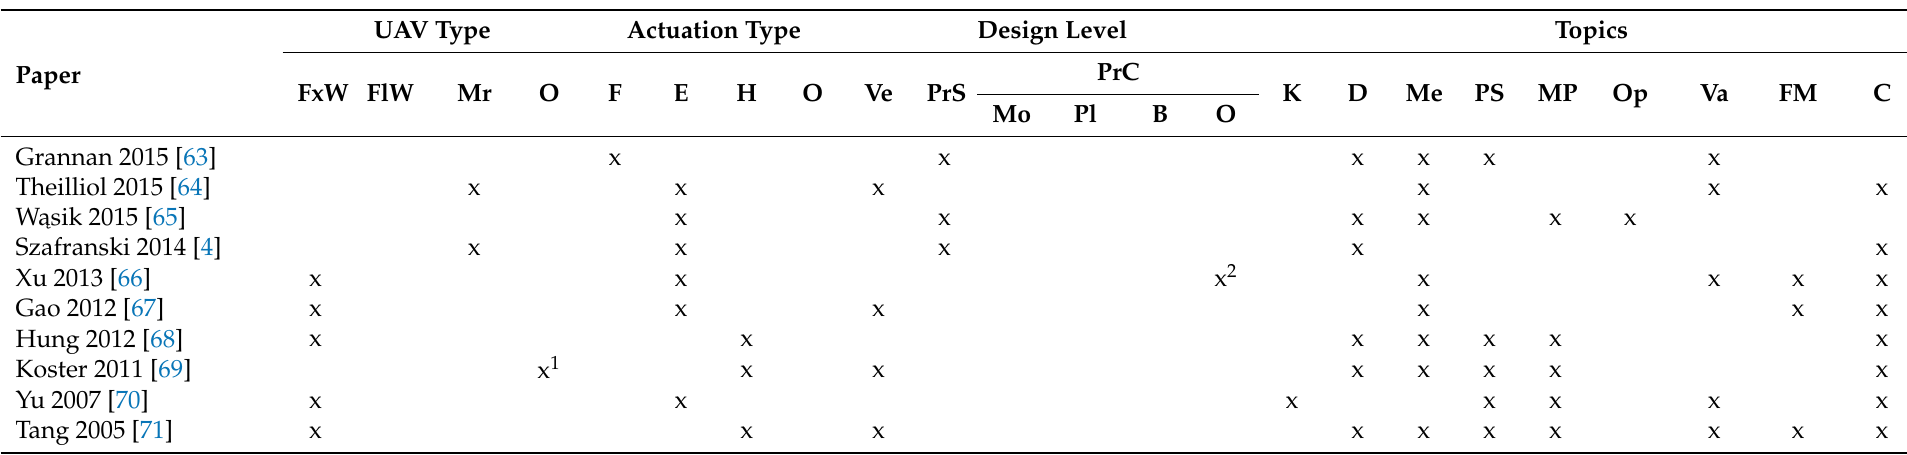
Table 7. Evaluation of the papers categorized in the controls, identification, modeling category until 2015, according to the taxonomy referring to the paper